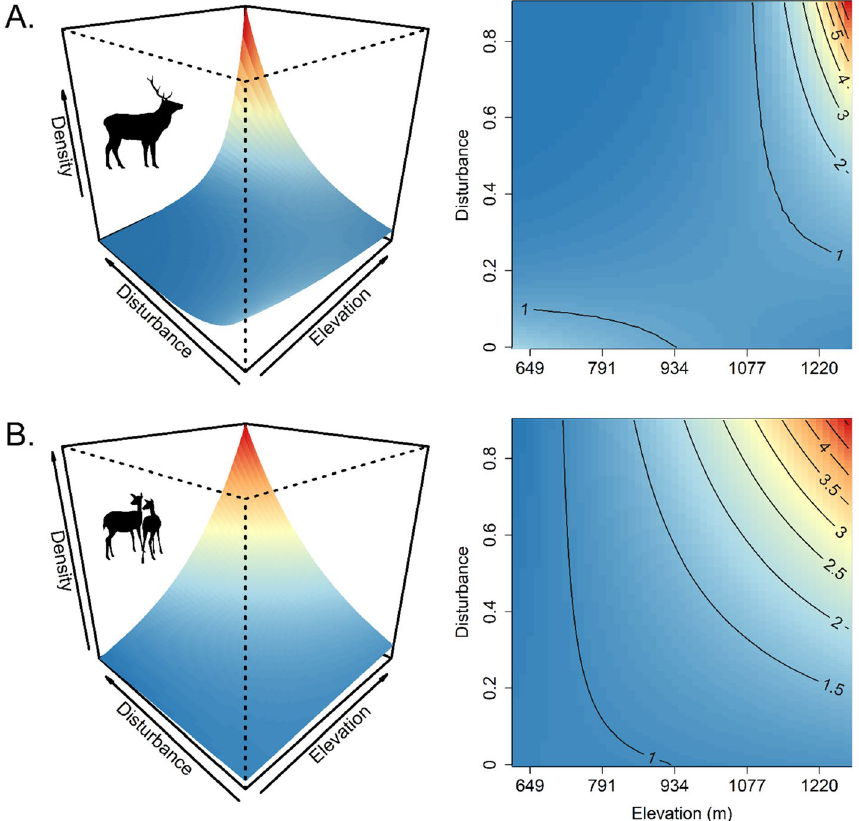
Figure 3. Sex-specific predictions of red deer relative density (individual per km −2 ) across the Bohemian Forest Ecosystem as a function of the interaction between proportion of forest disturbances and elevation ( A male, B female deer). Contour lines in the right-column plots represent relative density of red deer for each sex. All figures were created using R 59